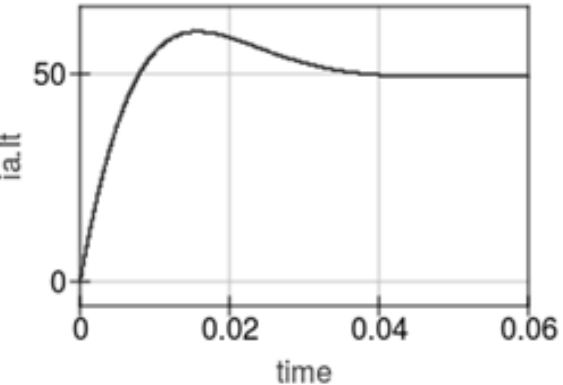
Figure 5. A simulation using Qucs of the armature current i a ( t ) under no-load conditions when using a supply voltage of v s = 100 V.